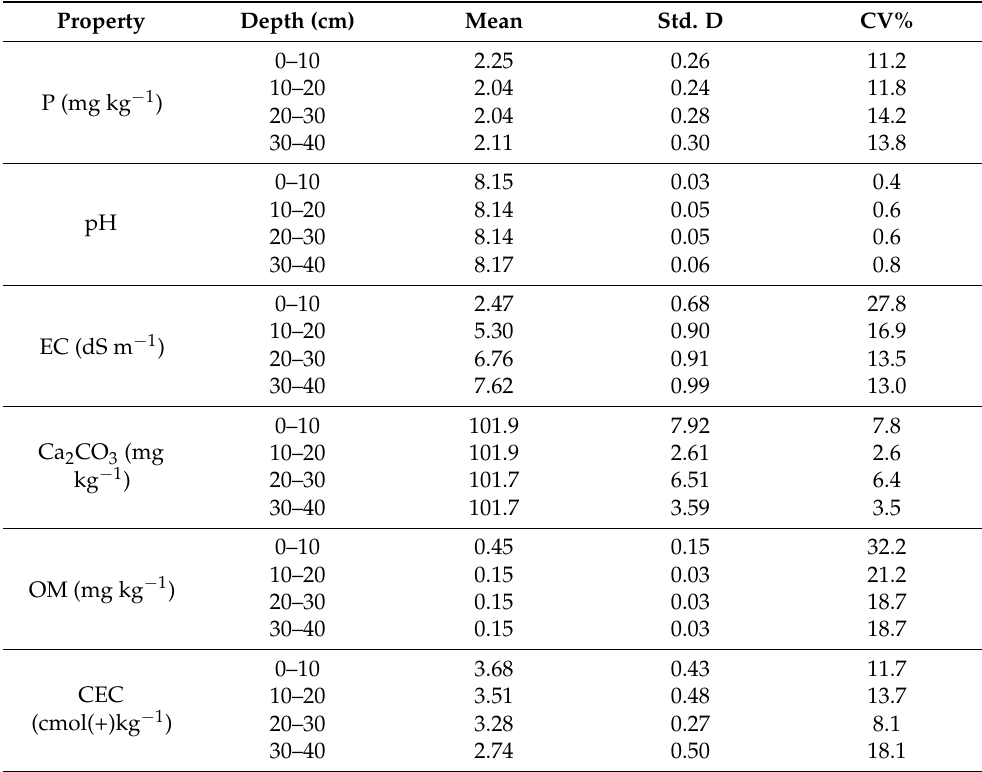
Table 1. Mean, standard deviation, and coefficient of variation for the selected properties of virgin soil ( n =